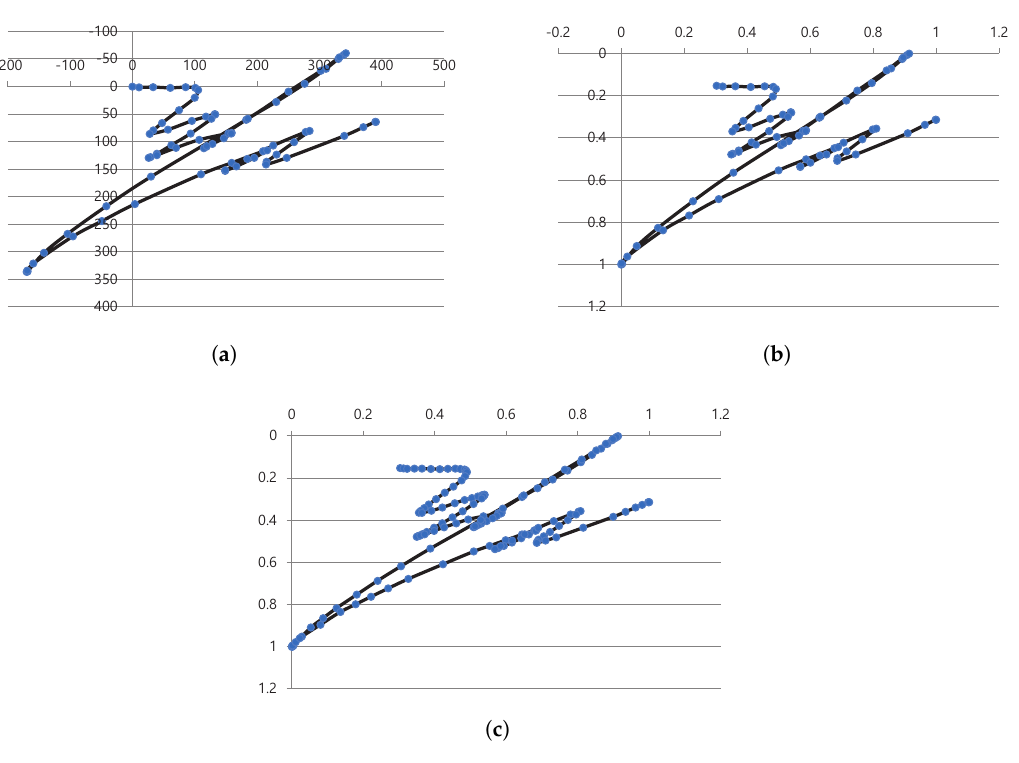
Figure 2. Data normalizations of: ( a ) alignment; ( b ) size; and ( c )